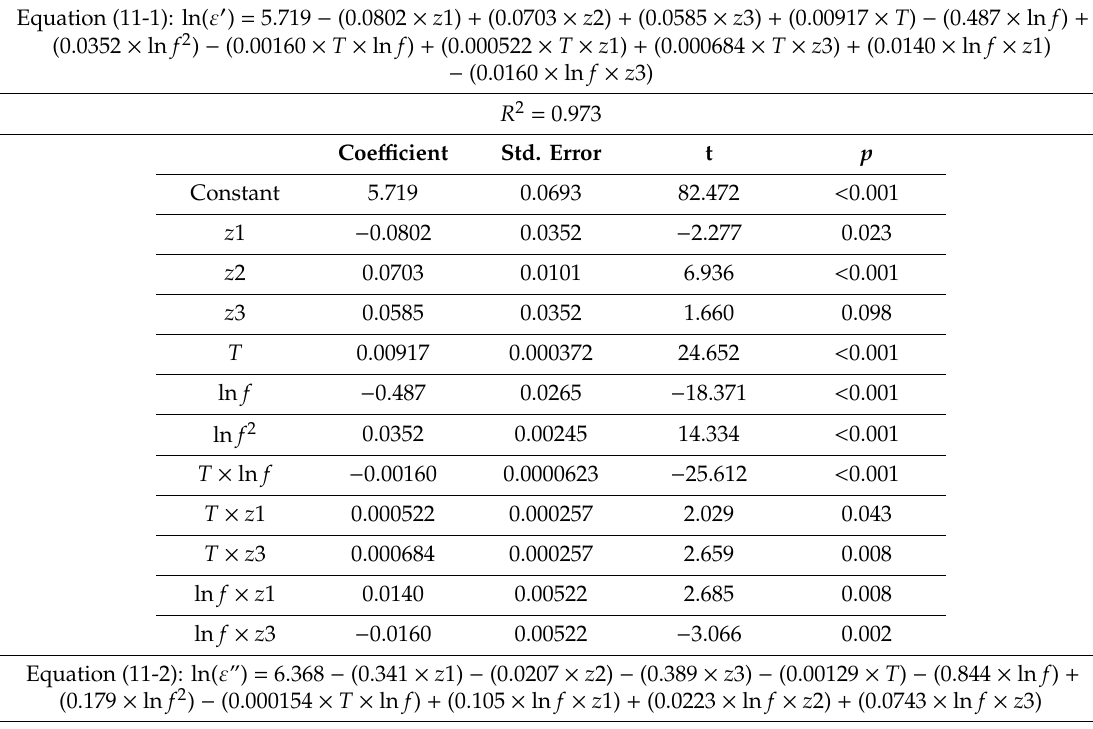
Table 11. Study of the e ff ect of four categories on the dielectric properties of salmon fillets using regression analysis. Position: Anterior, Middle, Tail,